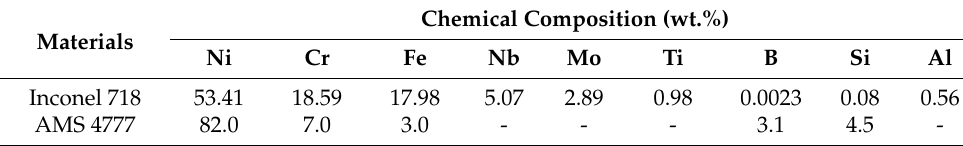
Table 1. Chemical composition (wt.%) of the materials used.